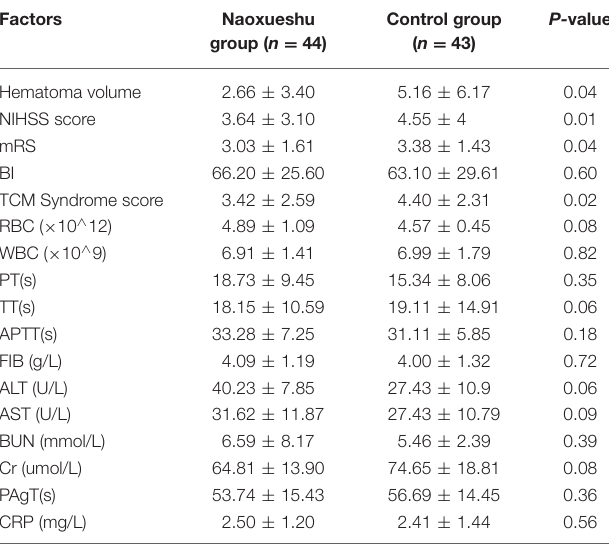
TABLE 4 | Comparison of the data of the 21st day after treatment between two groups.